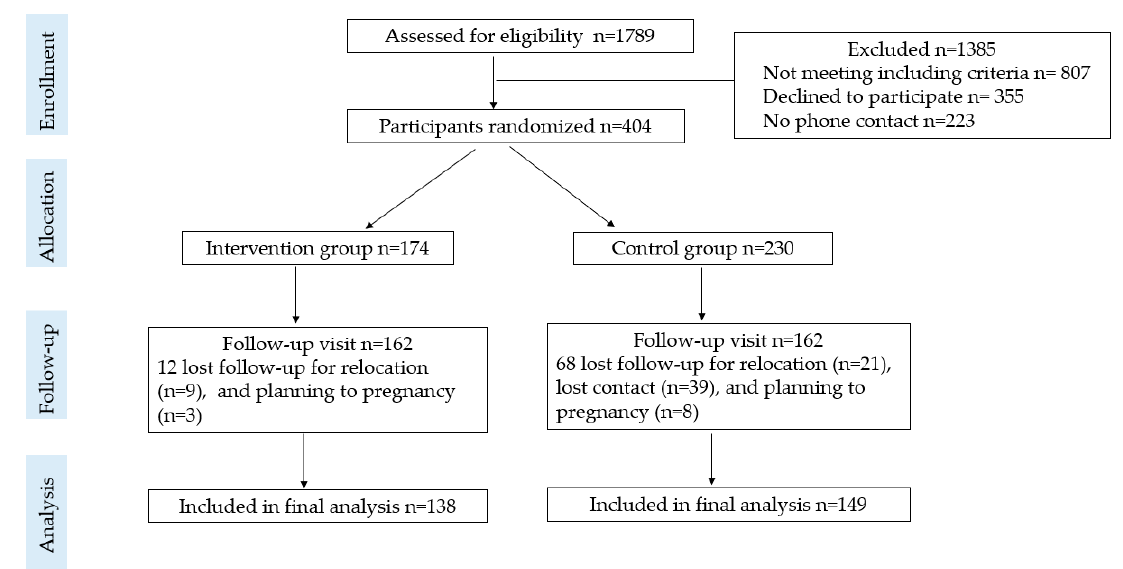
Figure 1. Flowchart of participant recruitment and allocation.